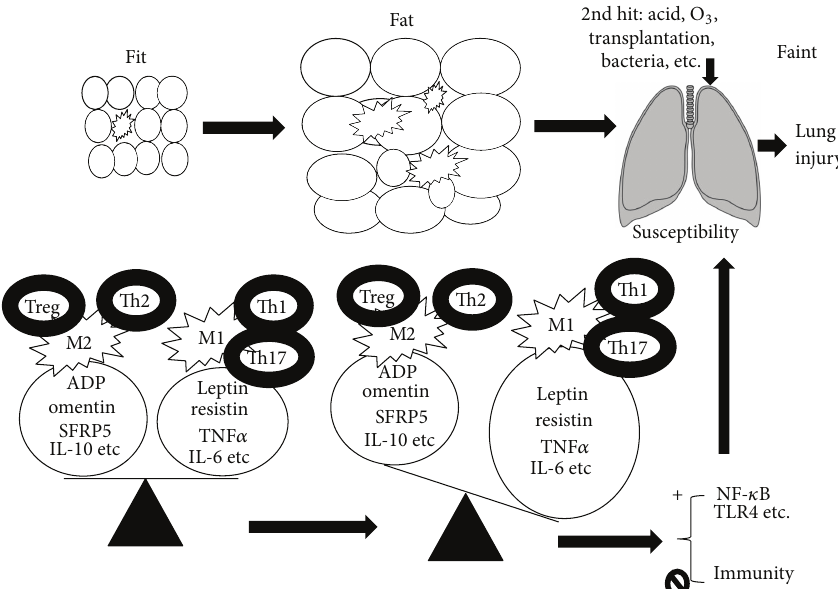
Figure 1: Fit-fat-faint: the overall mechanism of obesity, inflammation, and lung injury. In fit individuals, small fat cells secret proinflam- matory and anti-inflammatory adipocytokines. There are balances between these adipocytokines, macrophages M1 and M2, T helper cells Th1 and Th2, and Th17 and Treg. Under fat state, fat cells got larger and infiltrated by more macrophages and other cells, secreting more proinflammatory adipocytokines and causing an unbalance between proinflammation and anti-inflammation. These activate NF- 𝜅 B and TLR4 signaling pathways and decrease host immunity, thus increasing susceptibility of the lung. When the 2nd hit occurs, such as aspirated acid under obesity or debilitated conditions, O 3 in the air, bacteria, and surgeries, it is easier for the susceptible lung to get injured (faint). The final outcome depends on the overall balance. ADP: